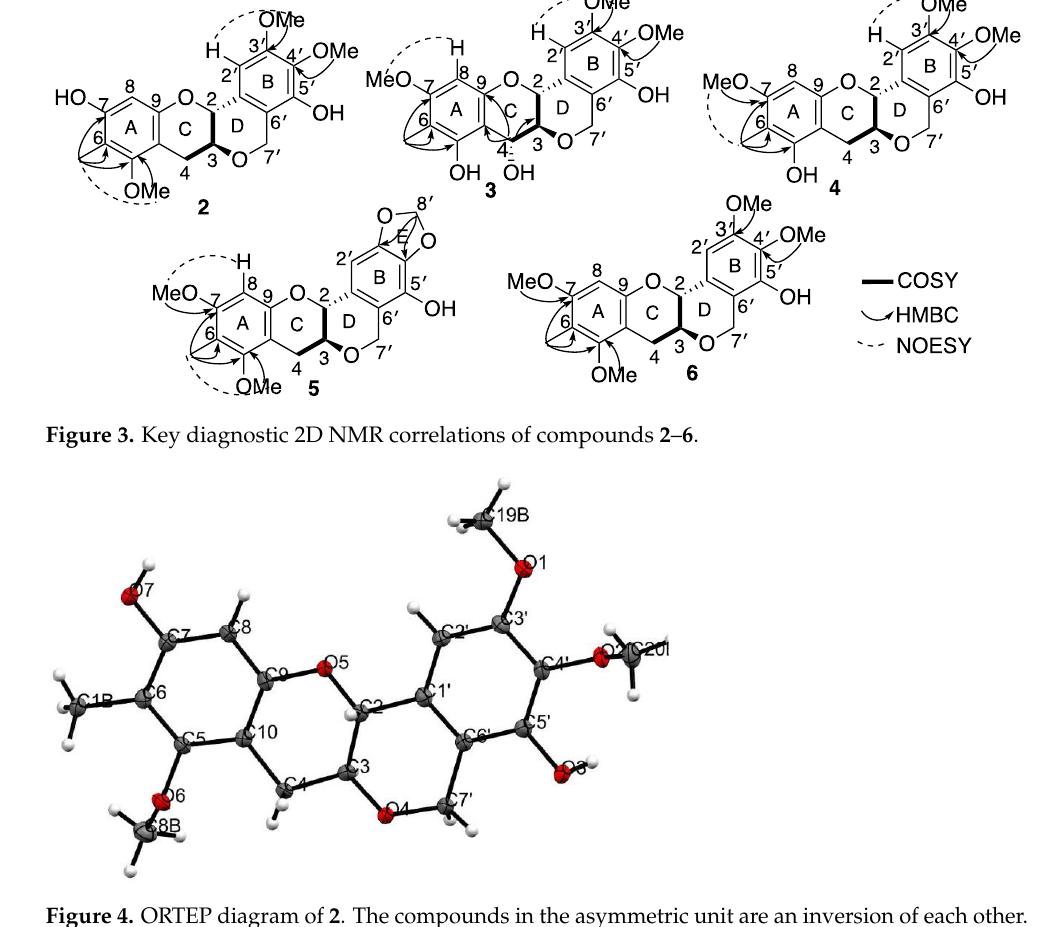
Figure 4. ORTEP diagram of 2 . The compounds in the asymmetric unit are an inversion of each other.